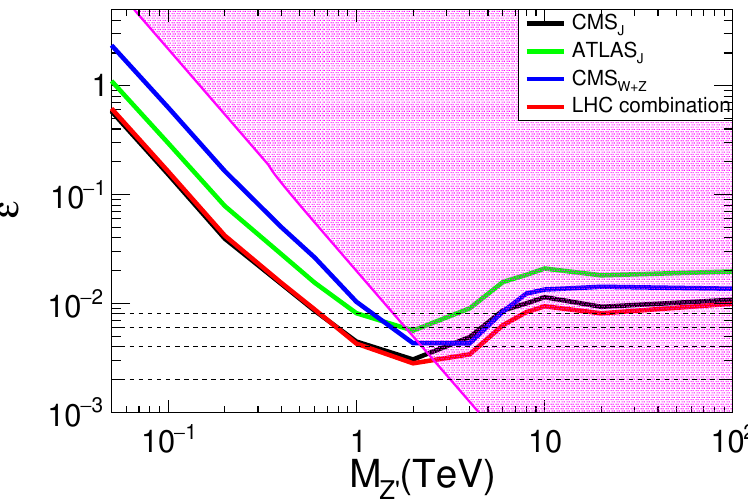
Figure 8. 95% CLs upper limit on NSIs in a simplified Z 0 model as a function of the mass of Z 0 with various measurements at the LHC and their combinations. We assume (cid:15) u = (cid:15) d = (cid:15) and Γ Z 0 /M Z 0 = 0 . 1 , and use the NLO predictions with theoretical